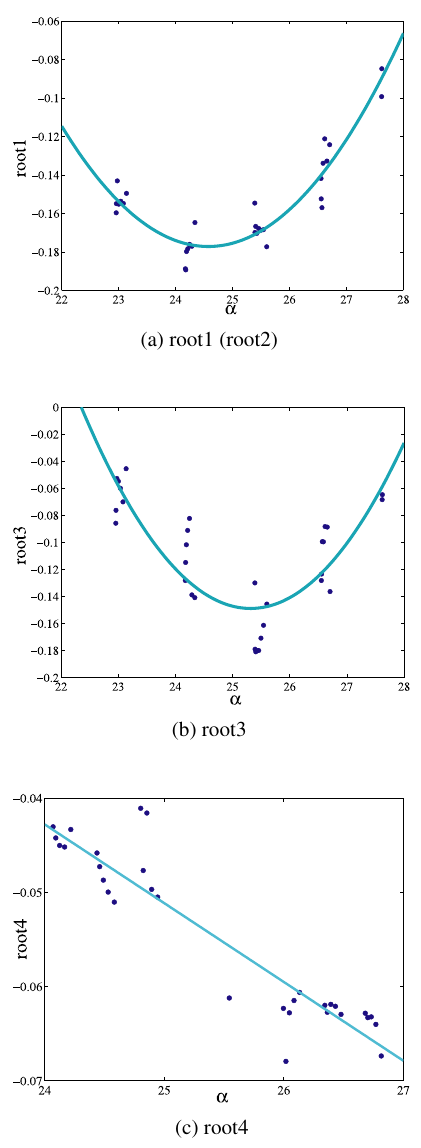
Fig. 8 Relationship between arch parameter α and real parts of roots (lateral)